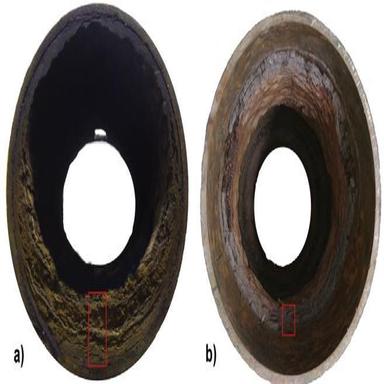
Pipes used for scale sampling (red regions) - a) Steel pipe and b) Composite pipe. (For interpretation of the references to colour in this figure legend, the reader is referred to the Web version of this article.)